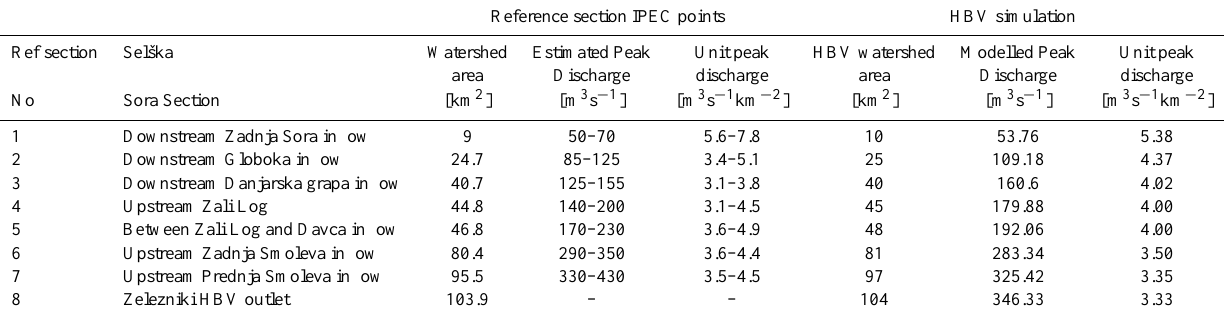
Table 4. Site names of IPEC points, IPEC subbasins’ areas, HBV model based subbasins’ areas, IPEC points estimated and model simulated peak discharges.